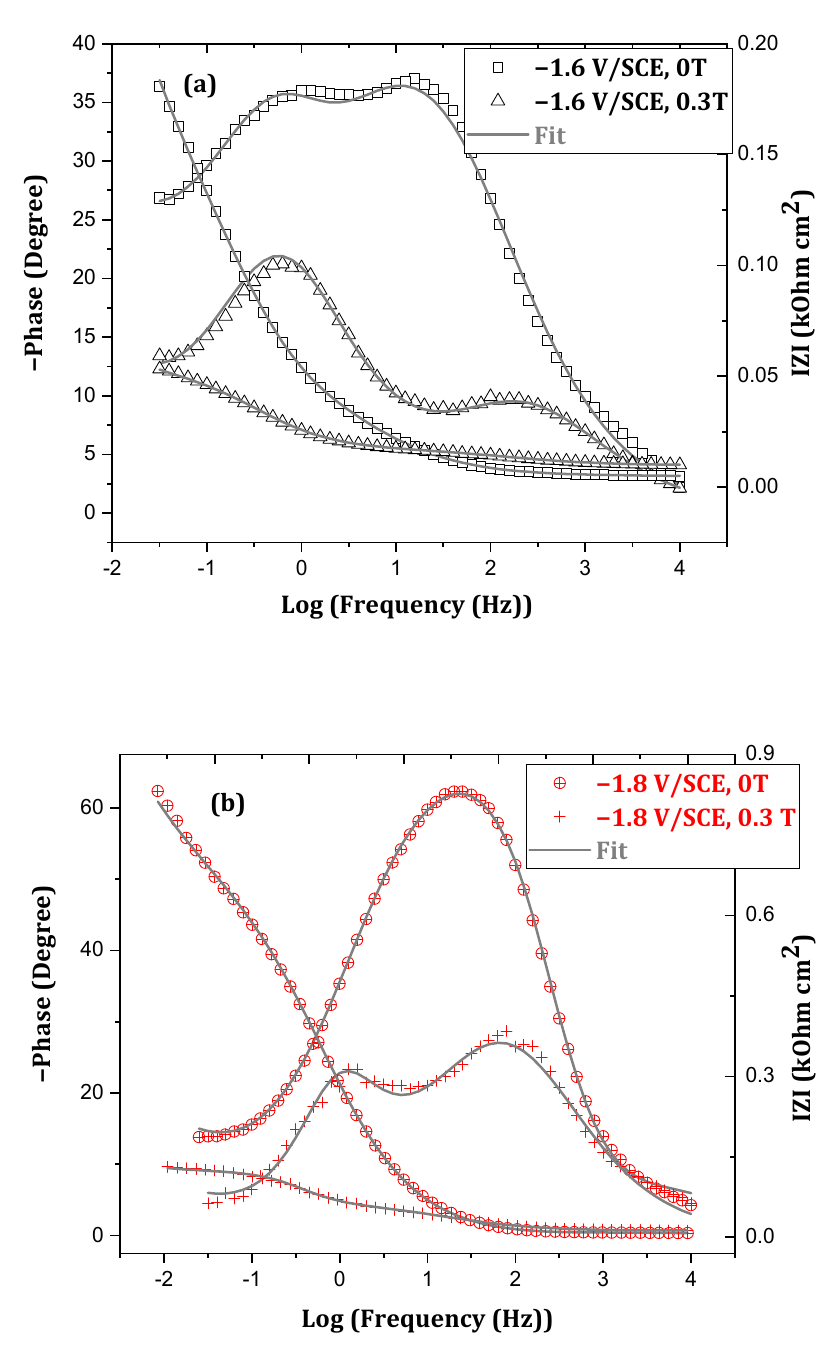
Figure 8. Bode plots for Zn–Mn alloy coatings electrodeposited for ( a ) B = 0 T, ( b ) B = 0.3 T and at two imposed potential E = − 1.6 V/SCE and E = − 1.8 V/SCE after 2 h of immersion in 3.5% NaCl solution.